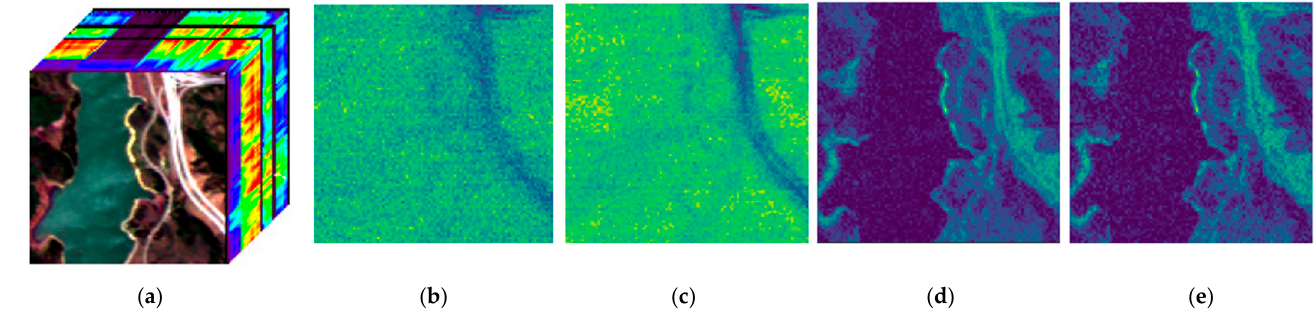
Figure 8. Hyperspectral image of ( a ) the Jasper Ridge data set. ( b ) Band 2. ( c ) Band 3. ( d ) band 223. ( e ) Band 224.